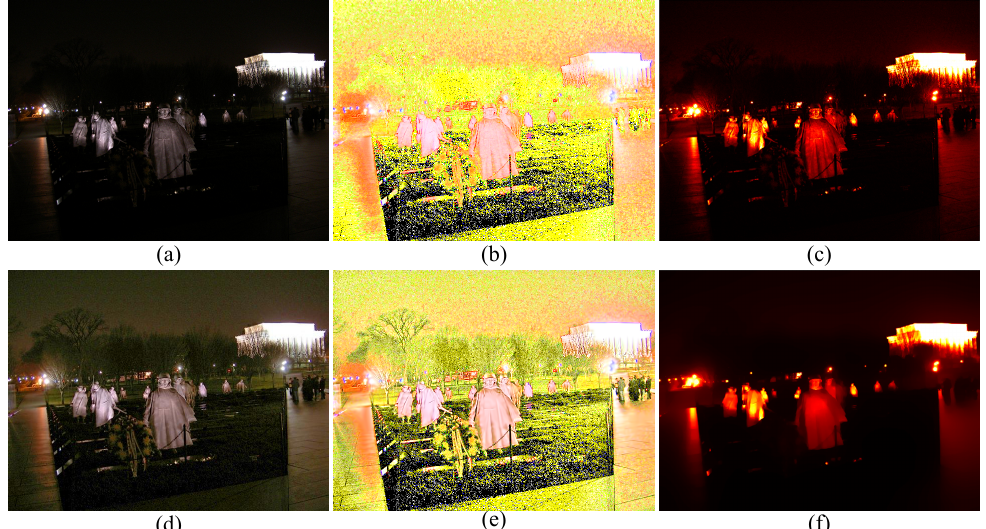
Figure 10. Visual evaluation of Retinex decomposition. ( a ) Original low-light image, ( b ) initial reflectance component ˆ R , ( c ) initial illumination component ˆ L , ( d ) corresponding enhancement result, ( e ) refined reflectance component R , ( f ) estimated illumination component L